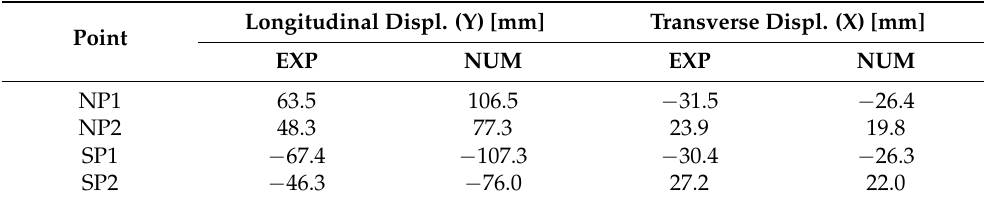
Table 3. Comparison between the experimental and numerical displacements of the investigated pylon points in C1 load configuration.